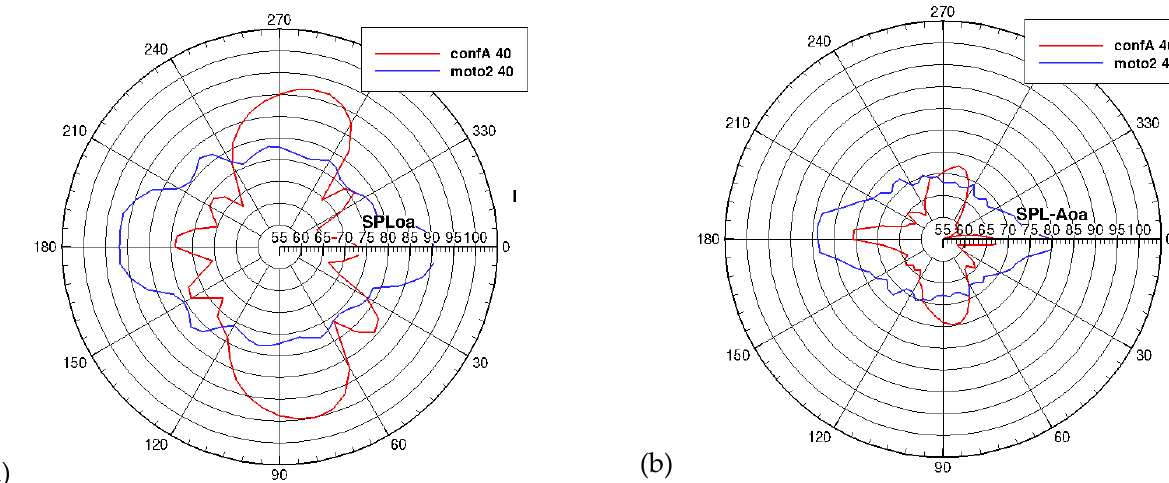
Figure 24. Comparison between Configuration A and Motorization 2; OASPL values on the horizontal XY plane ( a ), A-weighted values on ( b ). Flight condition Descent 40% ETR.